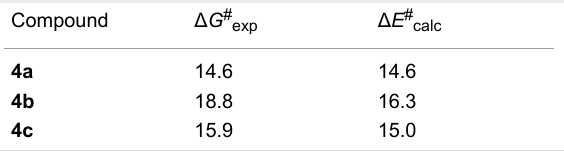
Table 2: Experimental and calculated (B3LYP/6-31+g**) rotational barriers (kcal/mol) in compounds 4a – c .